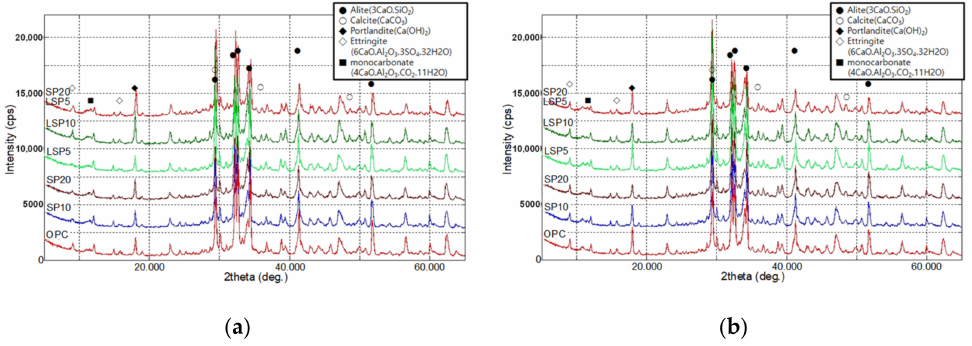
Figure 1. Compare of XRD pattern of mortar specimens at age: ( a ) 1 day; ( b ) 28